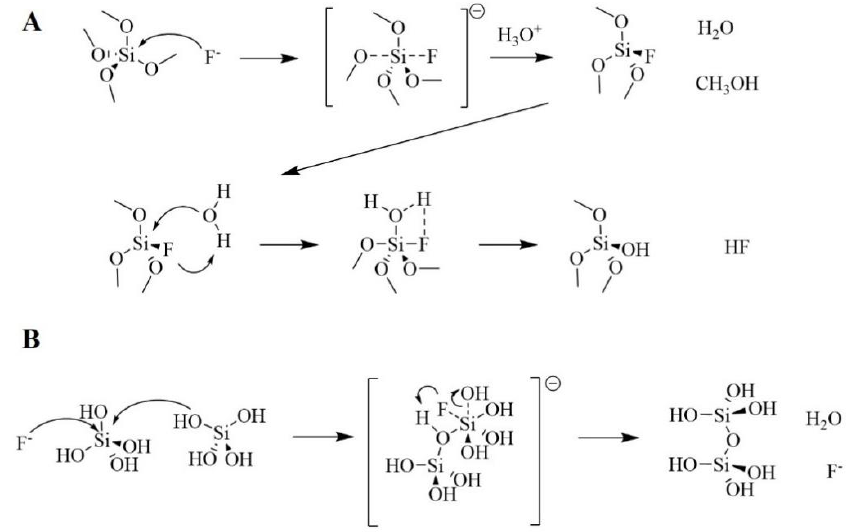
Figure 10. Fluoride-catalyzed hydrolysis ( A ) and condensation ( B ) of tetramethyl ortosilicate [34]. Reprinted with permission from [34]. Copyright 1986, Elsevier.